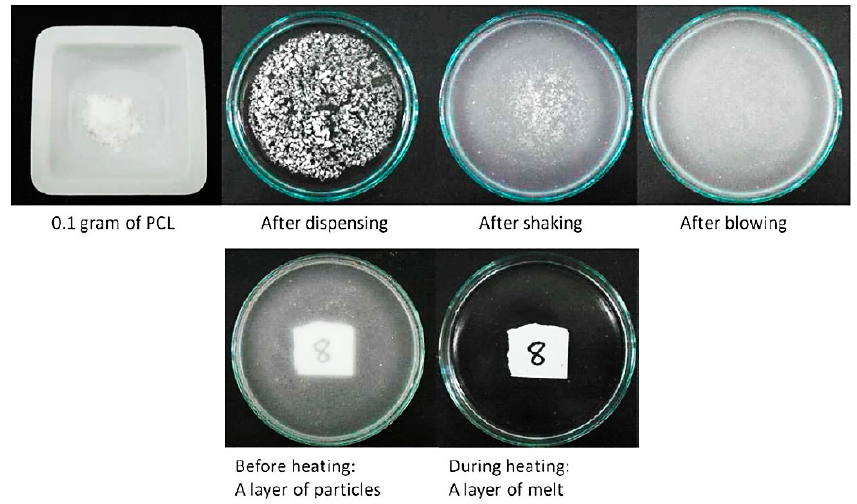
Figure 1. Preparation of a layer of PCL particles on the water surface and melting state layer formation in a 10 cm diameter glass dish.